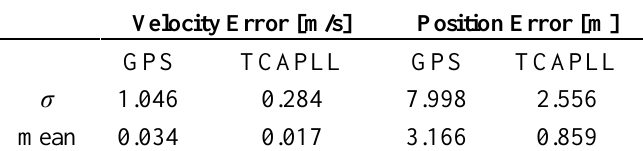
Table 2. Standard deviation and mean of the GPS and TCAPLL velocity and position errors.